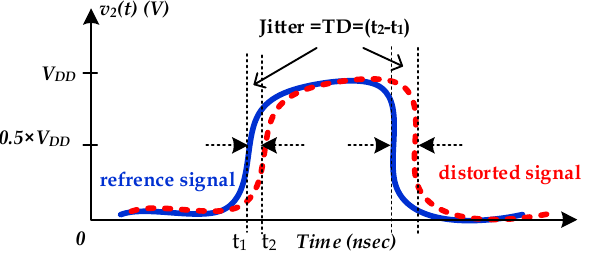
Figure 1. Illustration of timing distortion known as jitter occurring at the rising and falling transition of the output signal. Reference signal (solid blue line). Distorted signal (red dashed line).